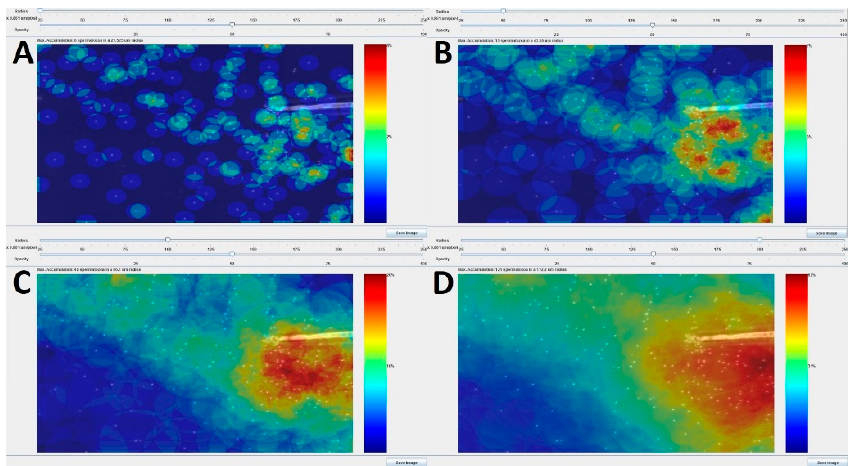
Figure A1. Heat maps provided by the Chemotactic Sperm Accumulation Module of the same frame processed with different radius values: ( A ) 25; ( B ) 50; ( C ) 100 and ( D ) 200 pixels. Scale: 0.861 µm/pixel.